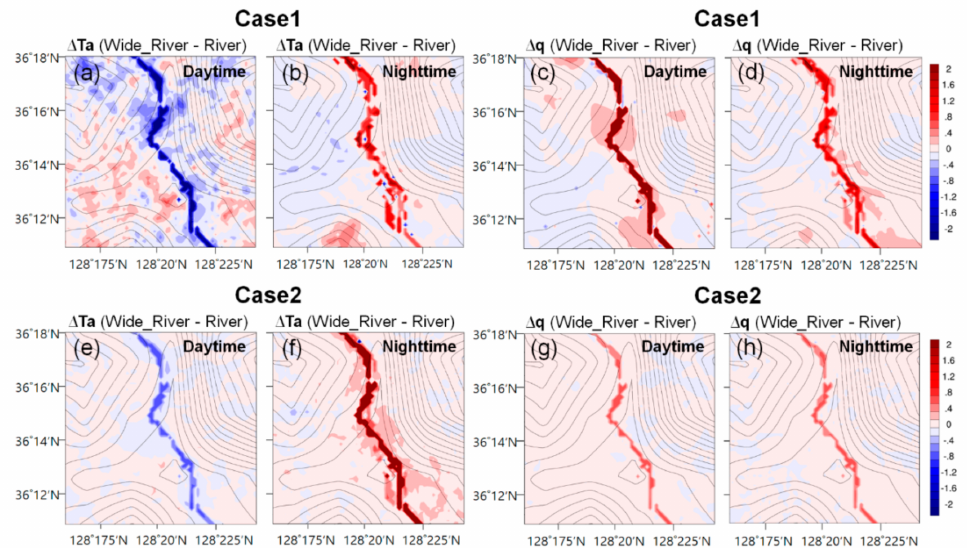
Figure 5. Horizontal distribution of the mean di ff erences between Wide_River and River (Wide River minus River) scenario for air temperature ( ∆ Ta; a , b , e , f ) and mixing ratio ( ∆ q; c , d , g , h ) at day ( a , c , e , g ) and night ( b , d , f , h ) for Case1 ( a – d ) and Case2 ( e – h ). The unfilled contours indicate a terrain height from 40 to 340 at intervals of